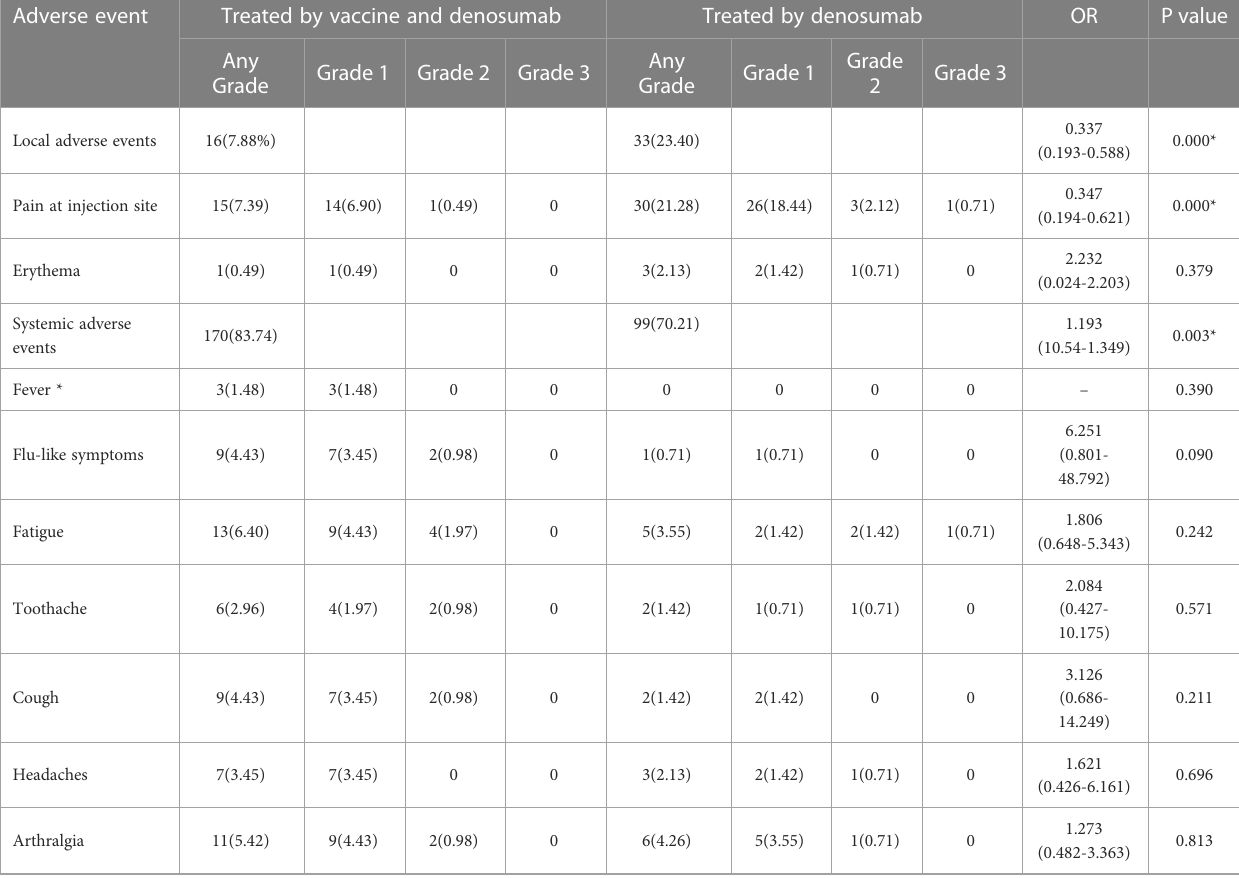
TABLE 4 Local and systemic adverse events reported after injection of the COVID-19 vaccine and